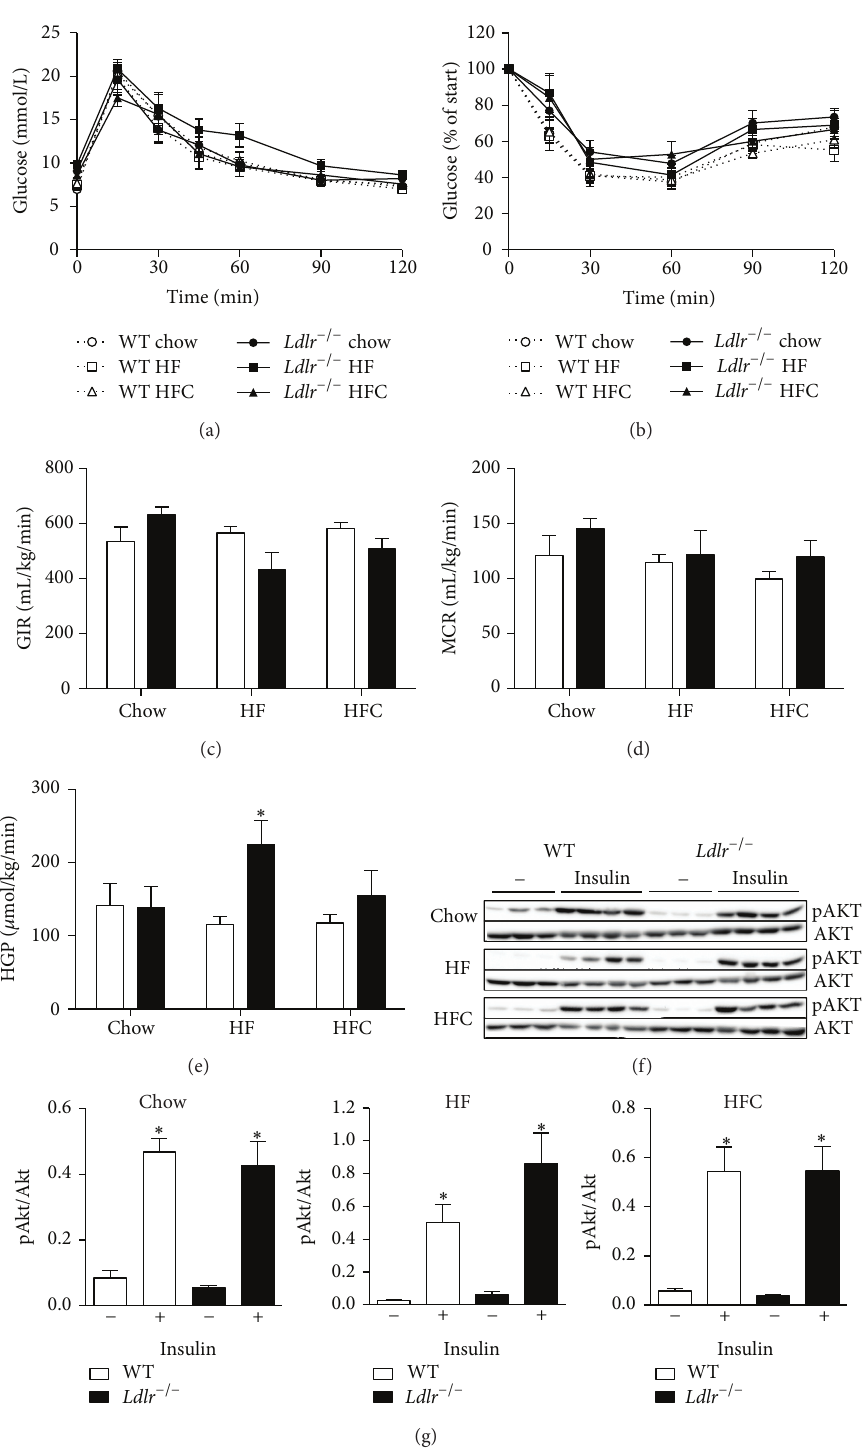
Figure 4: Hepatic inflammation does not induce hepatic insulin resistance in lean Ldlr −/− mice. To assess systemic insulin resistance, we performed an oral glucose tolerance test (a) and an insulin tolerance test (b) in WT and Ldlr −/− mice fed a chow, high-fat (HF), or high-fat cholesterol (HFC) diet ( 𝑛 = 5-6). To distinguish between hepatic and peripheral insulin resistance, a hyperinsulinemic-euglycemic clamp was performed during which glucose infusion rate (GIR) (c), metabolic clearance rate (MCR) (d), and hepatic glucose production (HGP) (e) were determined ( 𝑛 = 5–7). (f) Phosphorylation status of AKT in liver tissues obtained from WT and Ldlr −/− mice fed a chow, HF, or HFC diet sacrificed 15 min after saline ( 𝑛 = 5 ) or insulin injection ( 𝑛 = 7 ) and determined by Western Blot analysis. Data are expressed as means ± SEM for WT mice (white bars) and Ldlr −/− mice (black bars). ∗ 𝑃 < 0.05 WT versus KO; # 𝑃 < 0.05 HF, HFC versus chow; $ 𝑃 < 0.05 HF versus